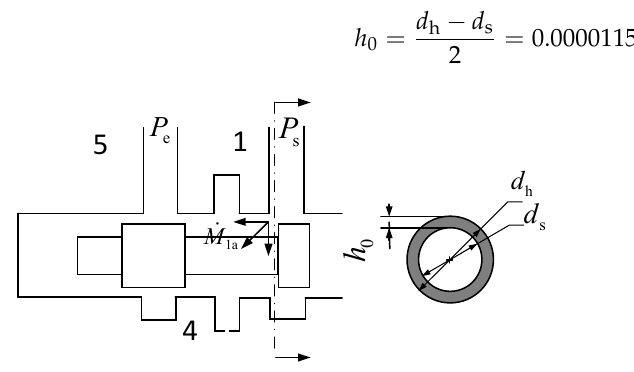
When the spool of the proportional directional control valve is moved to the right, two throttle holes are formed in the same vertical direction of the valve body. After passing through these two throttles, the gas enters the chamber or atmosphere of the cylinder, respectively. There is a slight gap between the sleeve and the spool, as shown in Figure 5, so the mass flow of the gas in the horizontal direction and the mass flow in the vertical . M 1a , where h 0 represents the gap between the spool and direction are the mass flow the sleeve; d h indicates the inner diameter of the sleeve, with a value of 0.006023 m; d s represents the outer diameter between the spool tables, with a value of 0.006 m; and h 0 is: .